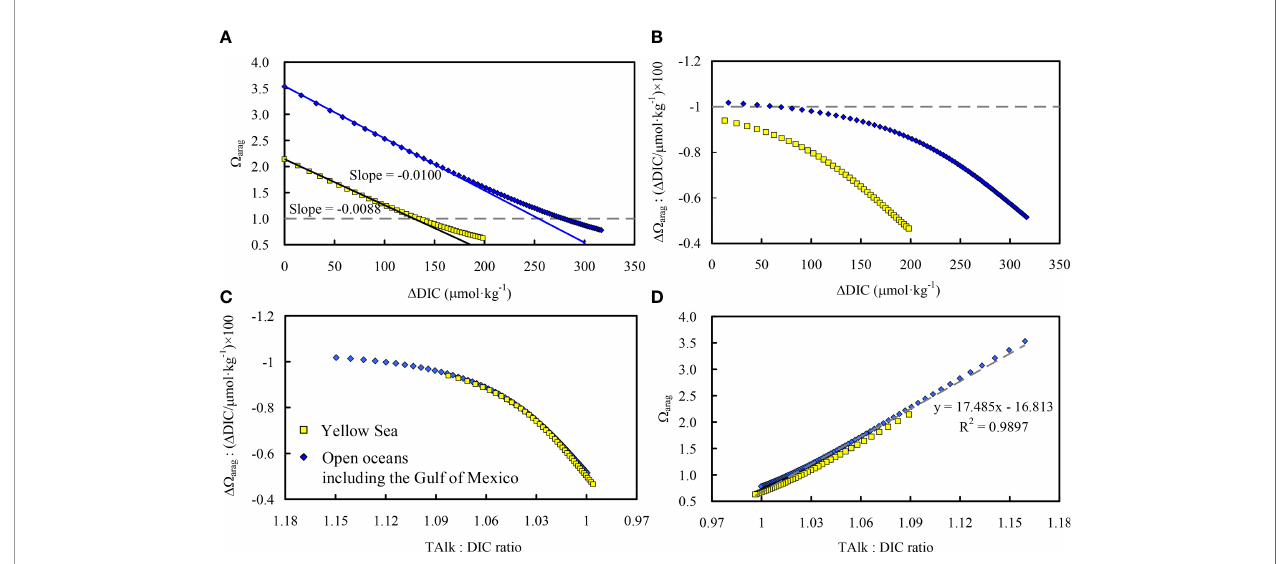
FIGURE 13 | Relationships of W arag and the sensitivity index of W arag (to D DIC) versus D DIC (A, B) and versus the TAlk : DIC ratio (C, D) in the Yellow Sea cold water mass and the open ocean surface. D DIC means CO 2 addition, either from net community respiration or from atmospheric CO 2